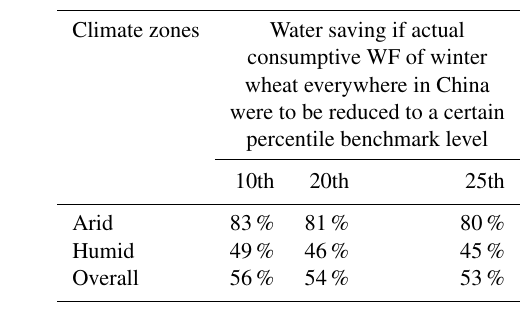
Table 7. Water saving if actual consumptive water footprint (WF) of winter wheat everywhere in China were reduced to the climate- differentiated WF benchmark levels set by the 10th, 20th, and 25th percentiles of production, in an average year